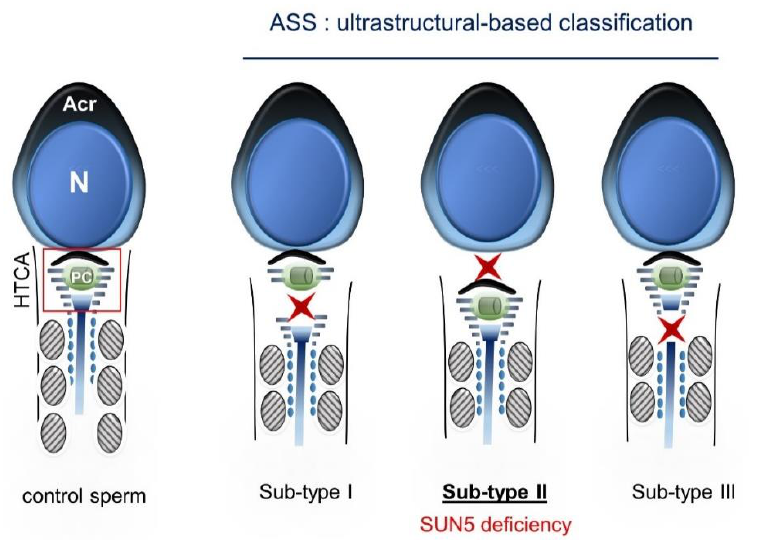
Figure 5. Ultrastructural-based classification of acephalic spermatozoa syndrome (ASS). Red star markers indicate the breakage level of the head–tail coupling apparatus (HTCA), defining three ASS sub-types. SUN5 deficiency leads to sub-type II, marked by the disruption of the junction between the nuclear envelope and the proximal centriole (PC). Acr: acrosome; N: nucleus. The ultrastructure of acephalic spermatozoa from individual P0504 observed